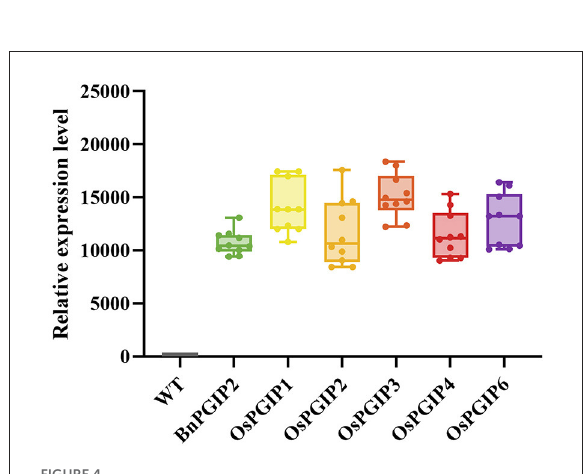
FIGURE4 Relative expression of OsPGIPx in transgenic rapeseed plants. Ten individual plants in T 0 generation of each PGIP transgenic rapeseeds were subjected to expression